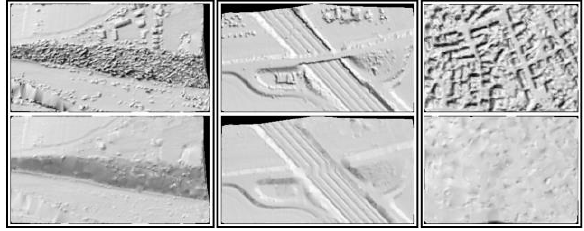
Figure 7. Original (top) and ground-filtered (bottom) data for selected